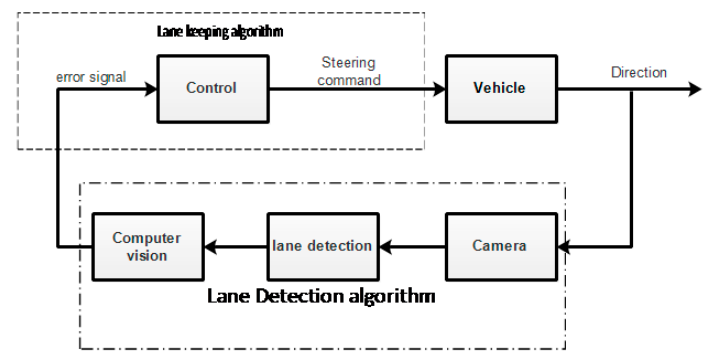
Figure 2. Block diagram of the lane-keeping